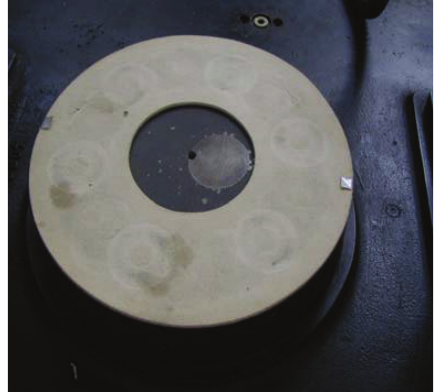
Figure 6: The elastomer of felt on the machine.